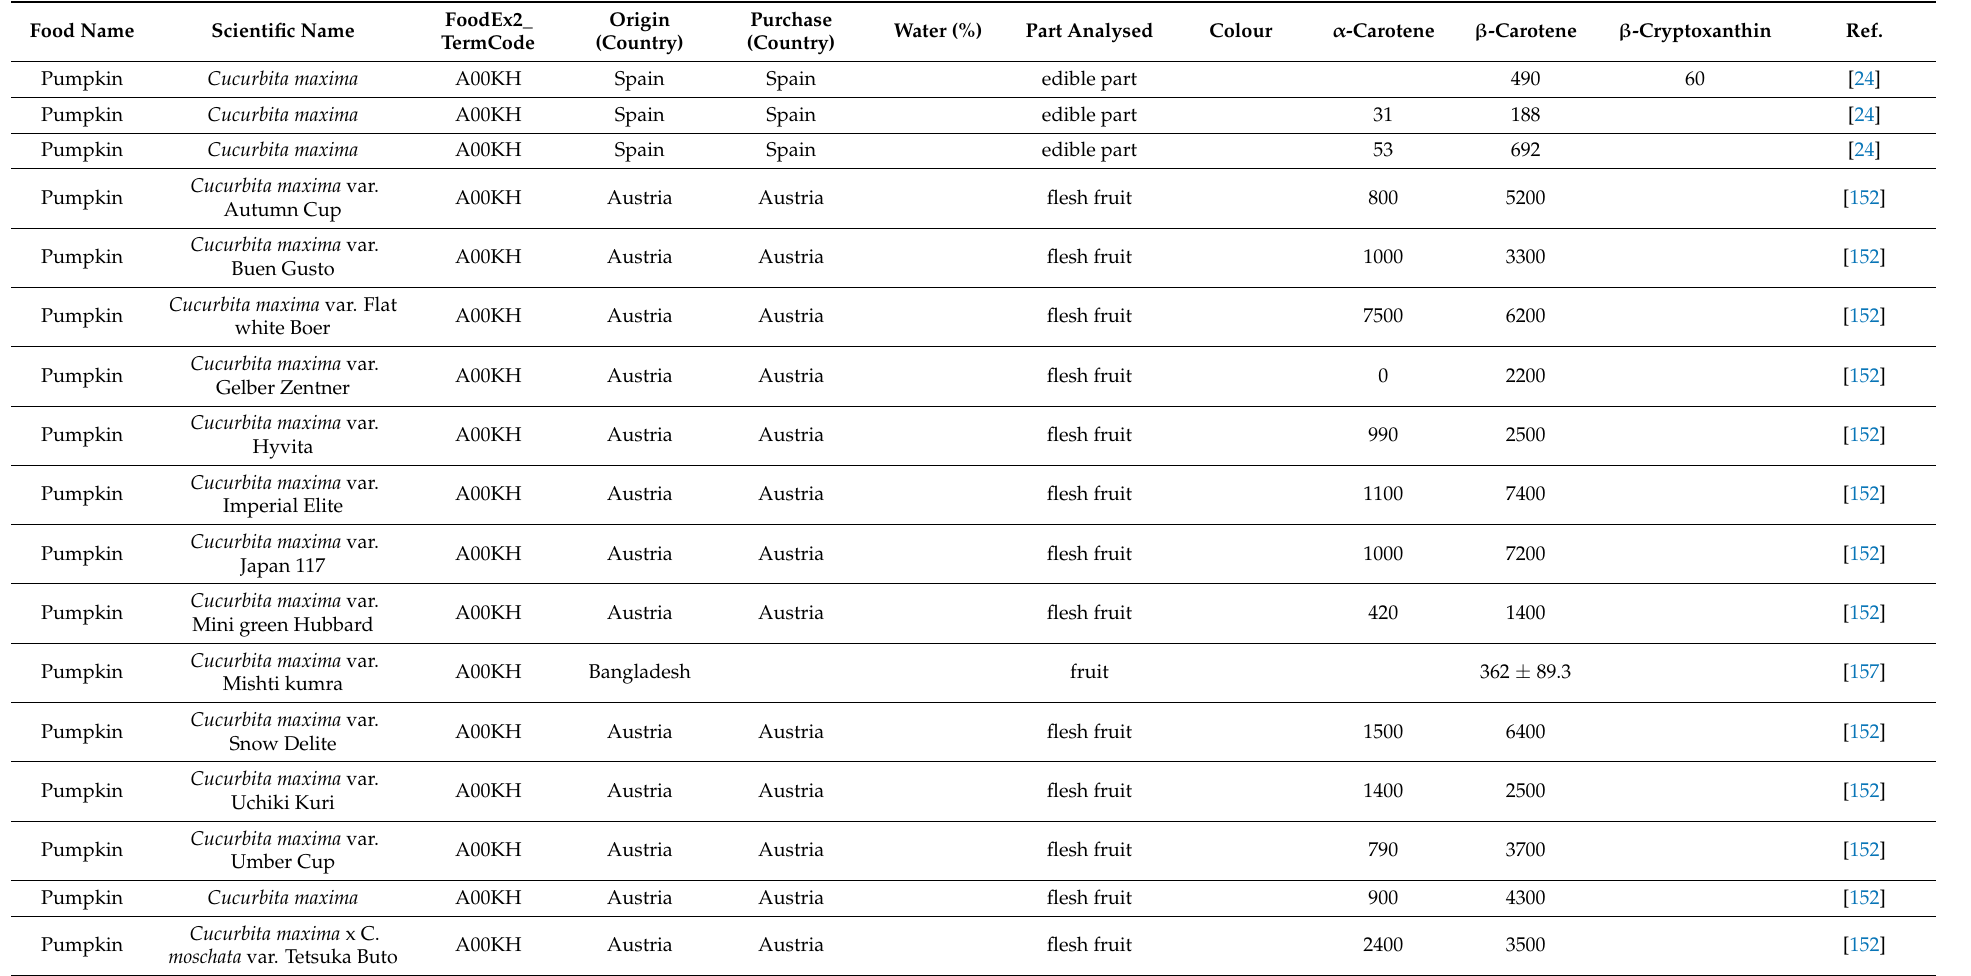
Table A5. Cucurbits with inedible peel (A00KD) ( µ g/100